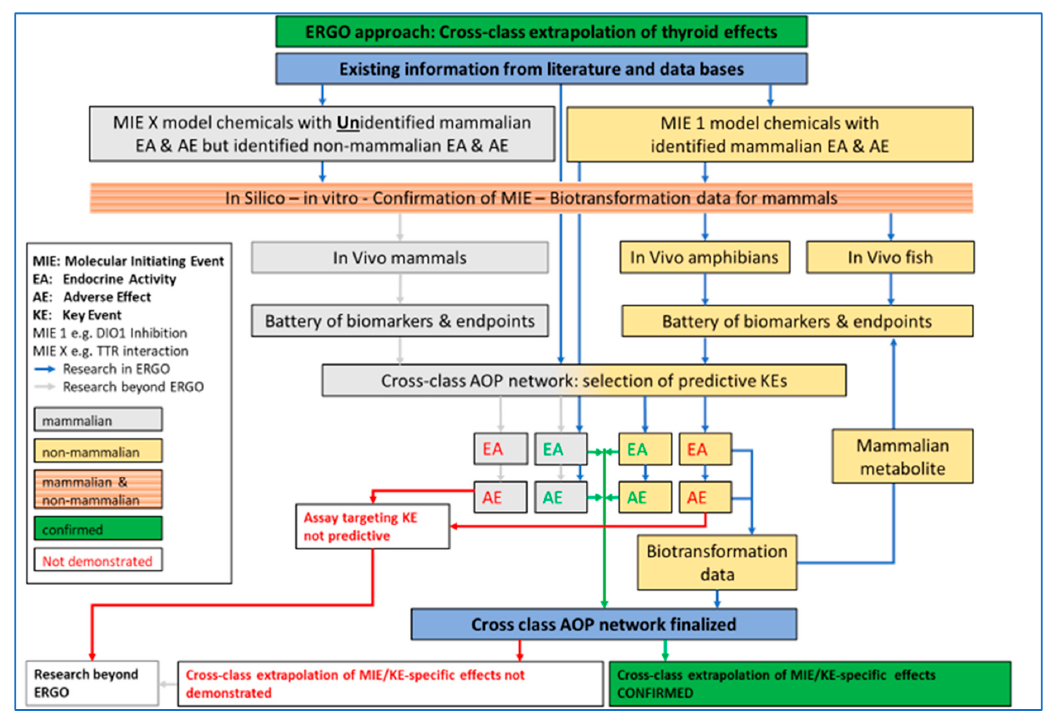
Figure 1. ERGO (acronym for EndocRine Guideline Optimization) approach for testing and cross-class extrapolation of THD (thyroid hormone disruption) e ff ects between mammalian and non-mammalian test guidelines. Based on existing information, chemicals with known molecular initiating events (MIE), key event (KE), endocrine activity (EA) and adverse effect (AE) in mammals will be investigated in silico, in vitro and in vivo, in fish and amphibians. A battery of biomarkers and endpoints (B / E) will be tested for EA and AE confirmation in the in vivo studies. Biotransformation data will be obtained when EA and/or AE cannot be confirmed. All existing and new data will be used for AOP (adverse outcome pathway) network development. Chemicals with unknown effects in mammals but known EA and AE in non-mammalian vertebrates will be investigated in silico, in vitro and for di ff erences in biotransformation among mammals and non-mammalian vertebrates. Blue arrow: Research in ERGO, Grey arrow: Research beyond ERGO, Green arrow: confirmed cross-class extrapolation, Red arrow: cross-class extrapolation not demonstrated.